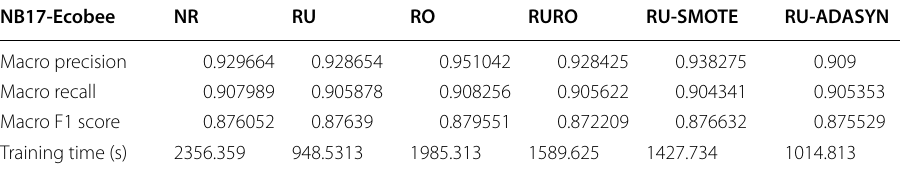
Table 39 ANN classification results for NB17-Ecobee on local machine for various resampling